Question: Draft a figure caption describing what is shown.
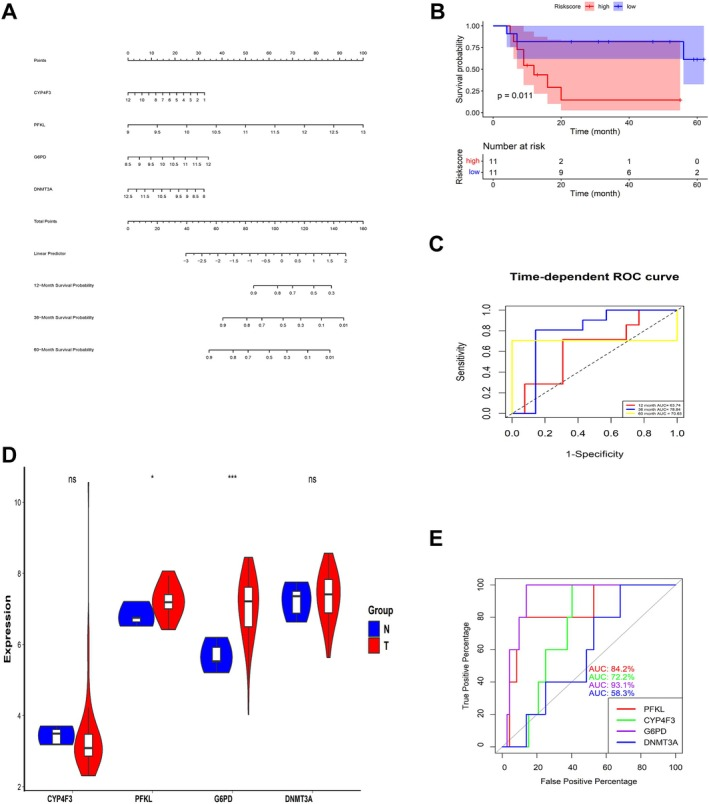
Answer: Nomogram construction, internal validation of the prognostic model, and external gene‐level evaluation in GSE68172 . (A) Nomogram for predicting overall survival in patients based on the expression levels of four hub genes (CYP4F3, PFKL, G6PD, and DNMT3A). The model integrates gene expression‐derived risk contributions to estimate the probability of 1‐, 3‐, and 5‐year survival. Each variable corresponds to a point value, and the total score is used to calculate the predicted survival probability. (B) Kaplan–Meier analysis of OS in the test cohort. Patients stratified into high‐ and low‐risk groups based on the metabolic gene‐derived risk score showed significantly poorer OS in the high‐risk group, supporting model generalizability. (C) Time‐dependent ROC curves for OS prediction at 12, 36, and 60 months in the test cohort, indicating stable discriminative performance. (D) Boxplots of MRPGs expression in AML and normal samples ( GSE68172 ). Expression of CYP4F3, PFKL, G6PD, and DNMT3A was compared between AML (T) and normal (N) groups. G6PD was significantly upregulated in AML (*** p < 0.001), and PFKL showed a modest increase (* p < 0.05), whereas CYP4F3 and DNMT3A were not significantly different (ns). (E) ROC analysis of MRPGs in GSE68172 . G6PD (AUC = 93.1) and PFKL (AUC = 84.2) showed stronger discriminatory performance than CYP4F3 and DNMT3A, supporting their potential diagnostic relevance in AML. AML, acute myeloid leukemia; AUC, area under the curve; CYP4F3, cytochrome P450 family 4 subfamily F member 3; DNMT3A, DNA methyltransferase 3 alpha; G6PD, glucose‐6‐phosphate dehydrogenase; MRPGs, metabolic‐related prognostic genes; ns, not significant; OS, overall survival; PFKL, phosphofructokinase liver type; ROC, receiver operating characteristic.